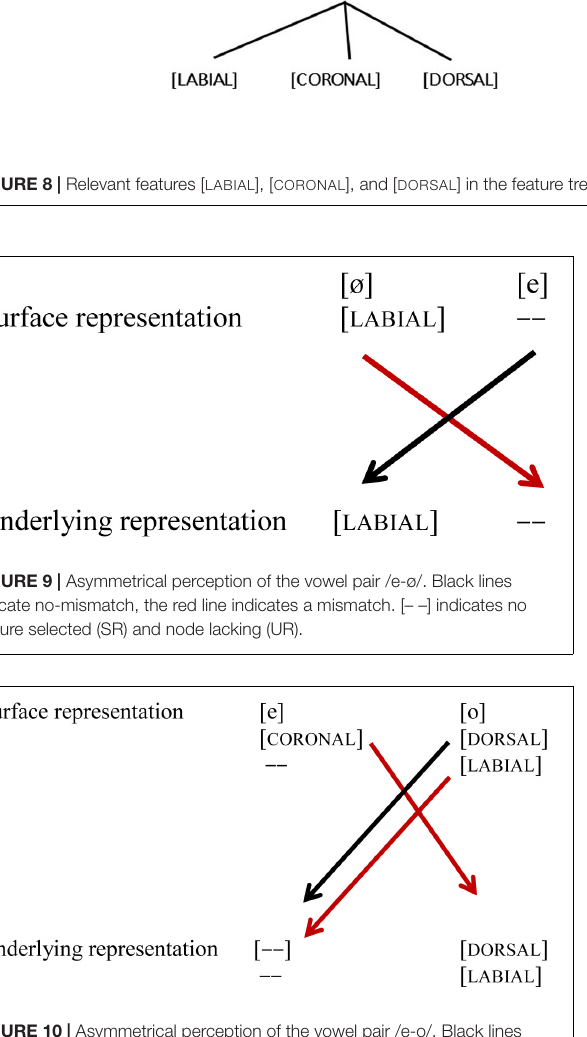
FIGURE 10 | Asymmetrical perception of the vowel pair /e-o/. Black lines indicate no-mismatch, the red line indicates a mismatch. [– –] indicates no feature selected (SR) and node lacking (UR). The matching for place of articulation and labiality shows conflicting results.